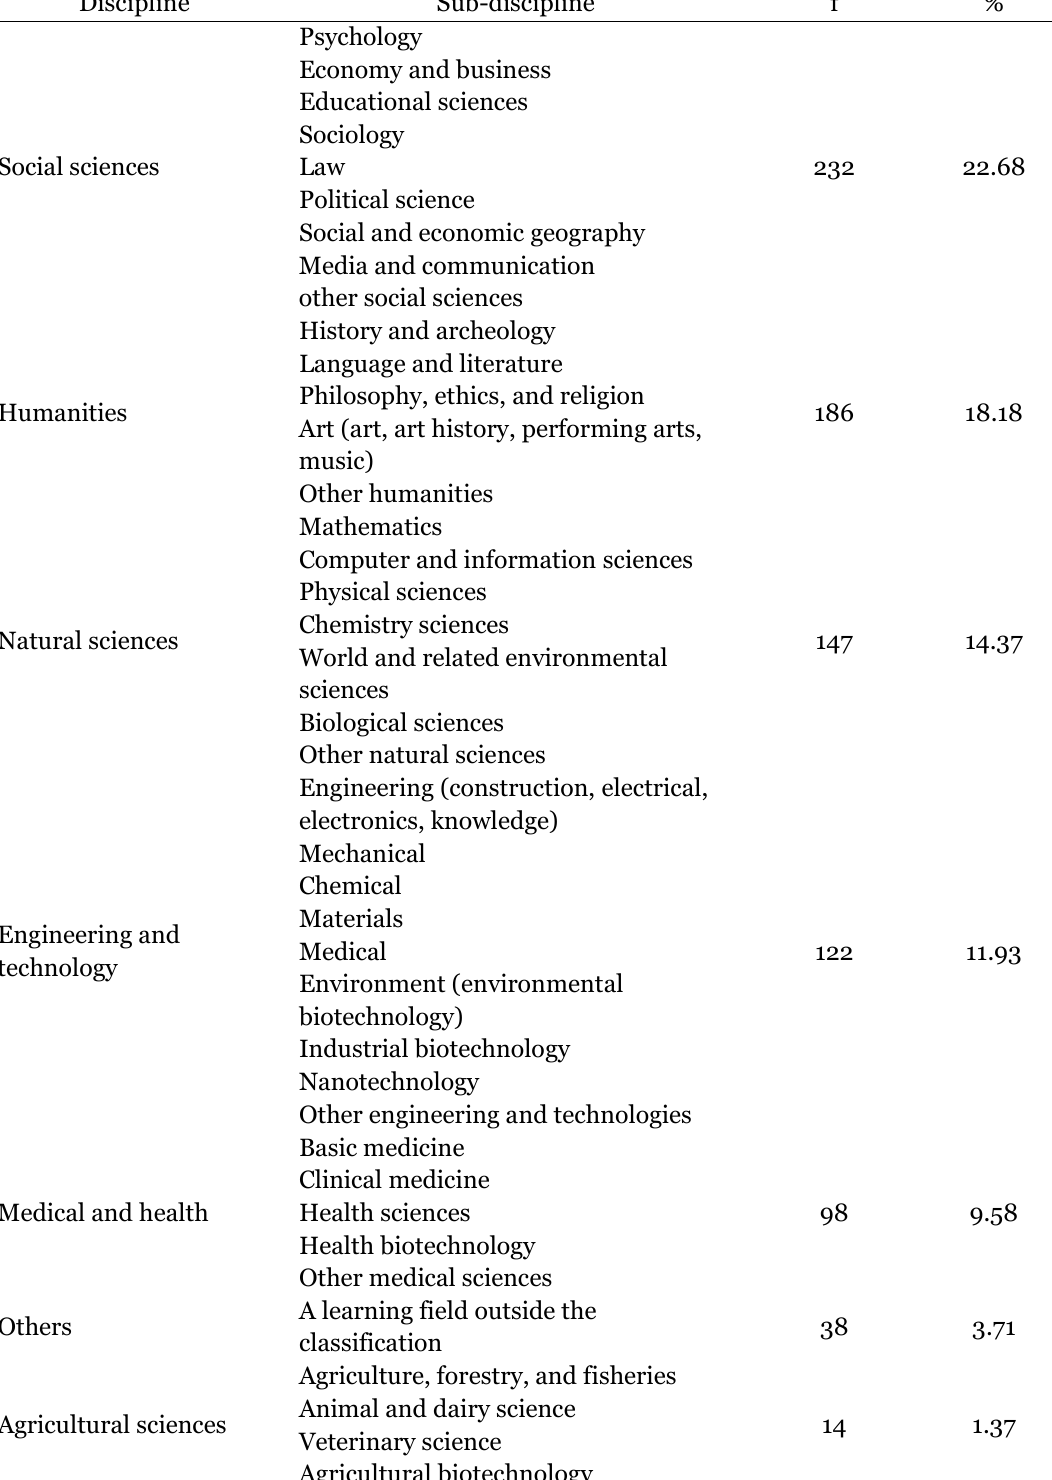
Distribution of Studies by Learning